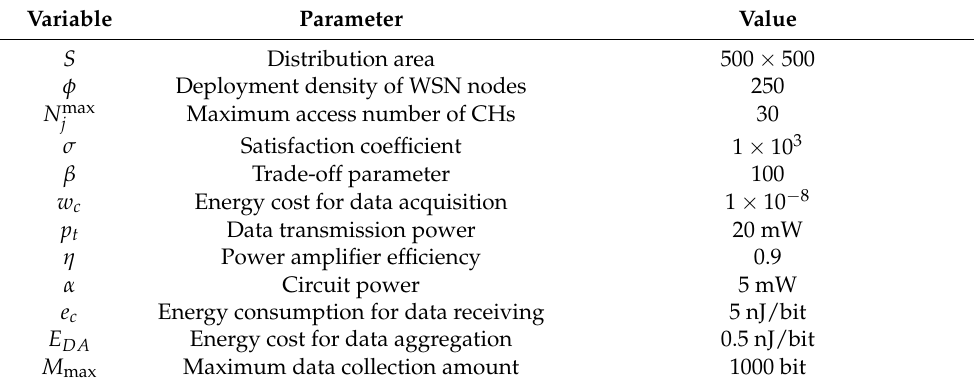
Table 2. Simulation